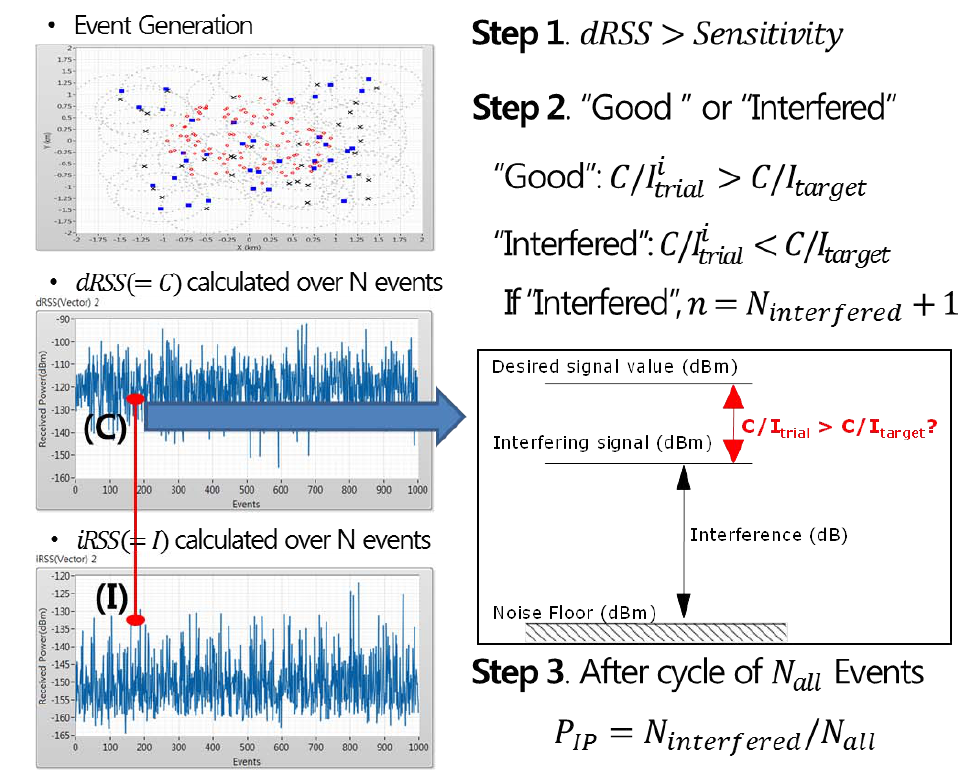
Figure 8. Interference probability